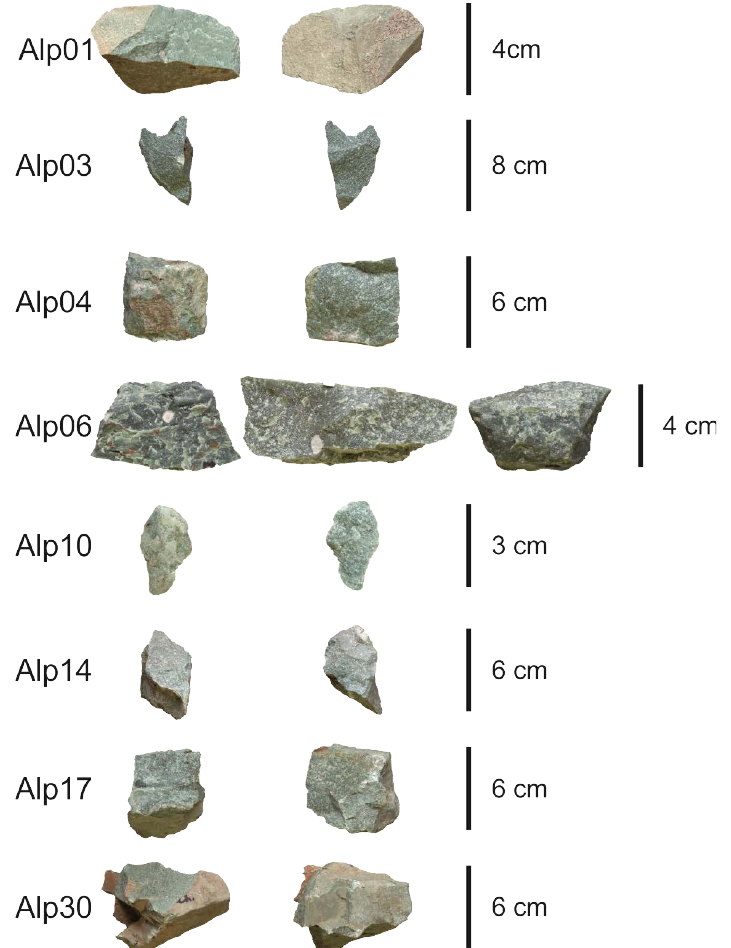
Figure 6. Photographs of the Alpine geological samples. See Table 1 for details. A general similarity with a minor variation in range can be observed from a petrographic point of view. Photos R. Fábregas and O. Lantes.